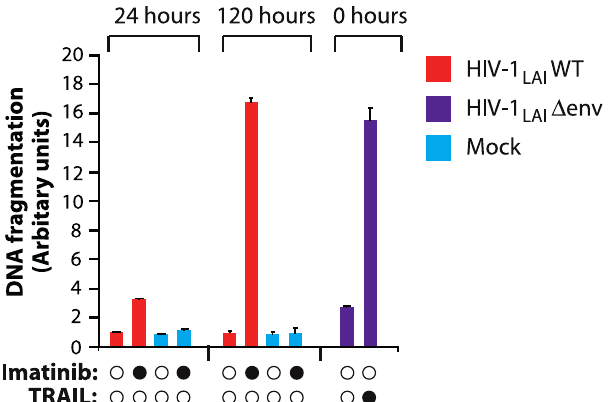
Figure 6. Prolonged Exposure to Imatinib Alone Is Sufficient to Induce Apoptosis in HIV-1–Infected